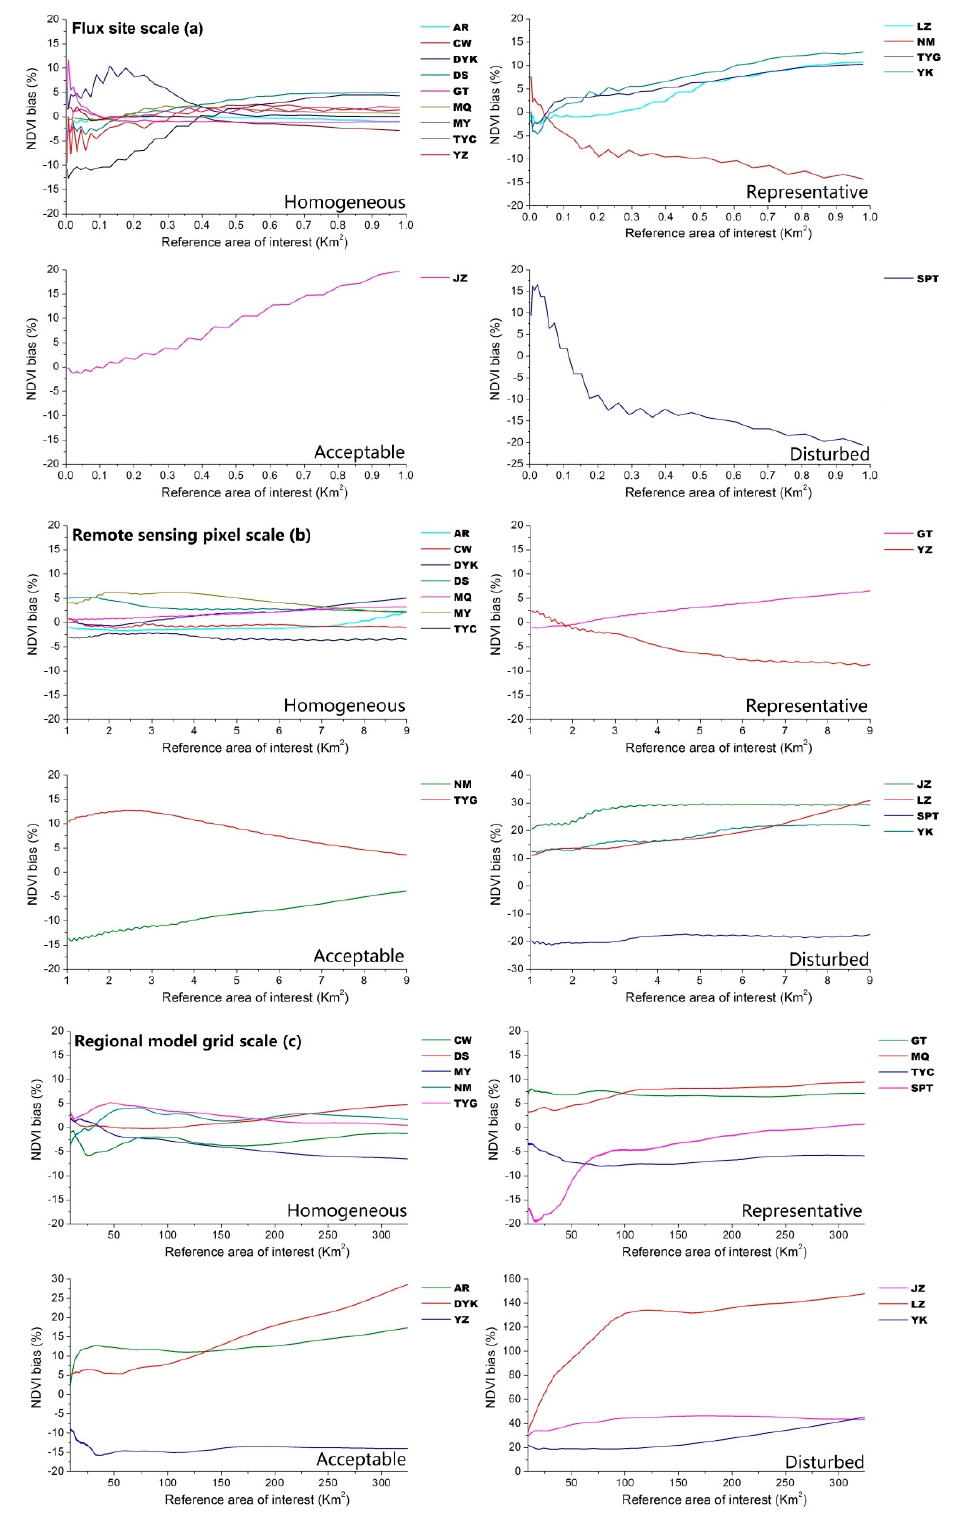
Figure 6. The reference areas were divided into three sub-scales: ( a) flux site scale (0 to 1 km 2 ); ( b ) remote sensing pixel scale (1 to 9 km 2 ); ( c ) and land model grid scale (9 to 324 km 2 ). For each sub-scale, sites were ranked as: homogeneous ( upper left ); representative ( upper right ); acceptable ( lower left ); and disturbed measurements ( lower right ).